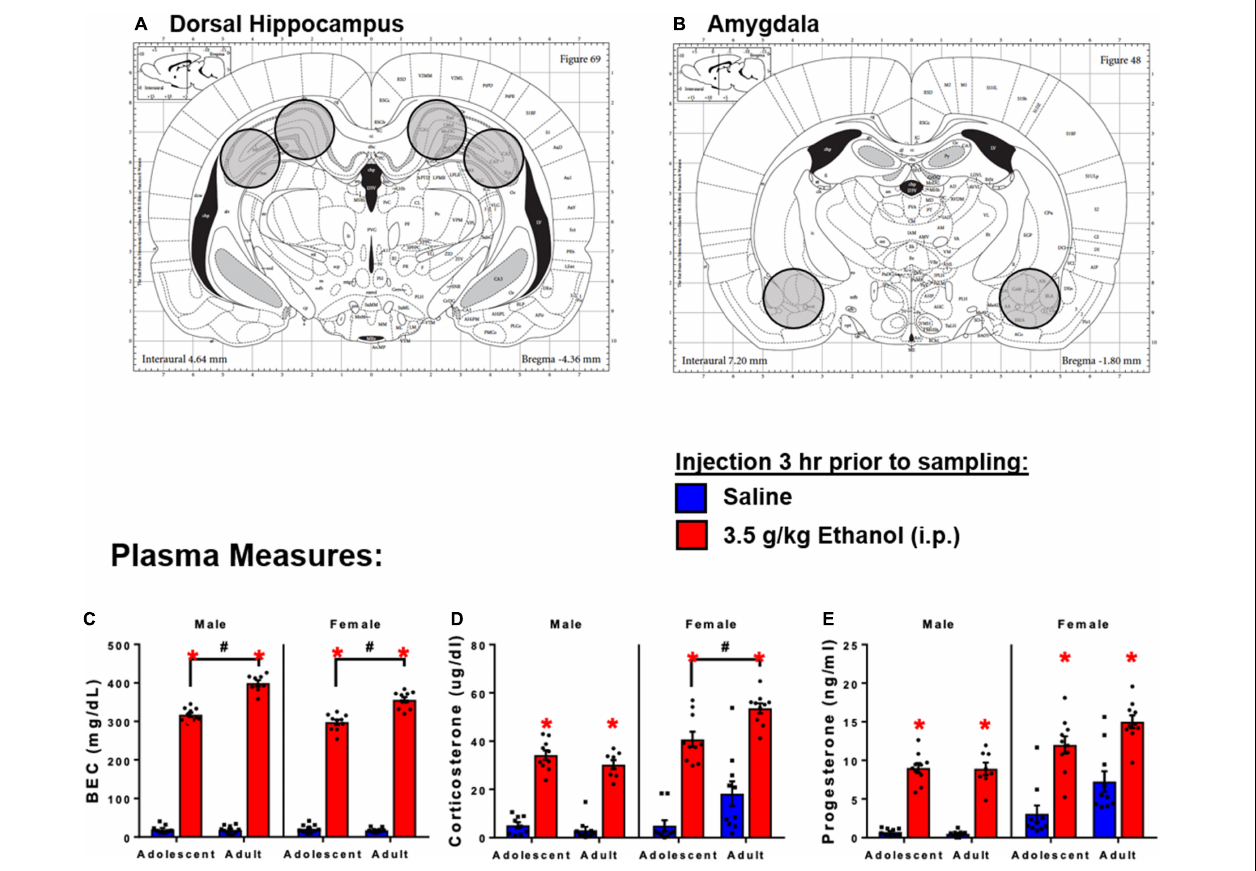
FIGURE 1 | Schematic diagram of tissue sections of brain regions of interest. (A) Dorsal hippocampus sections. (B) Amygdala sections. 3 h following 3.5 g/kg ethanol, there were increases in plasma. (C) BECs, (D) CORT, and (E) Progesterone. Asterisk ( ∗ ) and hash (#) indicate the main effect of